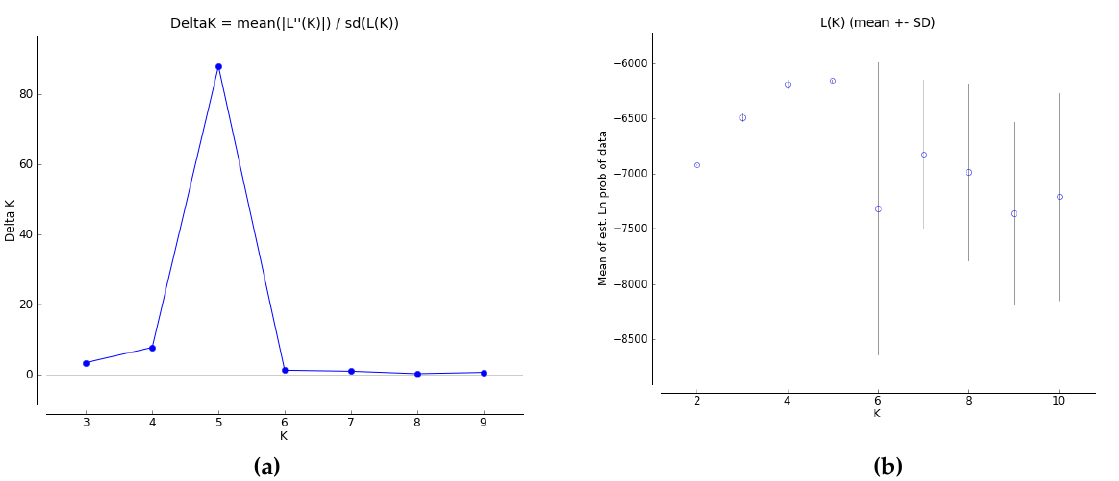
Figure 5. Line graphs from the mixture model of Ln P (D) and ∆K for bean populations ( a ); average value of the Ln P (D) statistics generated by the structure at each value of K ( b ); DK.